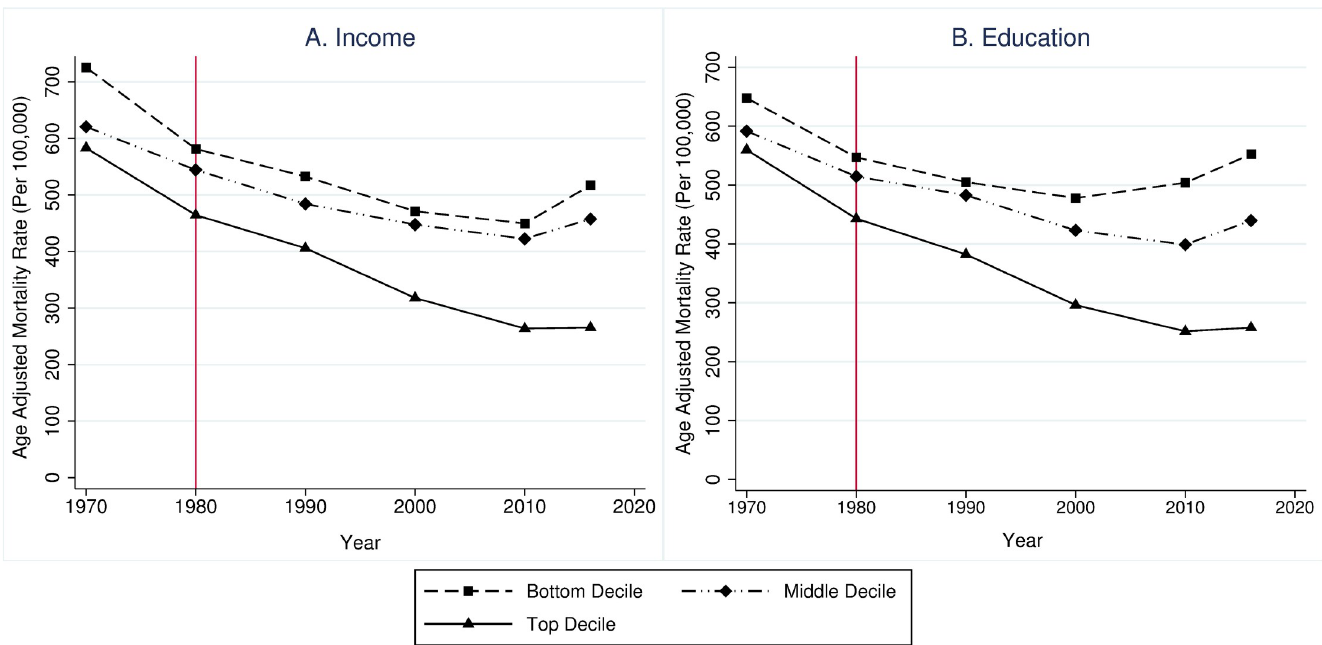
Fig 2. Age-adjusted mortality rates for working-age adults (ages 25–64 years) by county of residence per capital income and educational deciles, 1970–2016. County-level age-adjusted, all-cause mortality rates for adults ages 25–64 years were obtained from the US Centers for Disease Control WONDER database. Data on county-level per-capita incomes and share of individuals with some college education or greater were obtained from US Decennial Census and ACS data made available through Social Explorer. We assigned counties into deciles of the per-capita income and education variations by each census-ACS year (so a given county could be grouped into different deciles in different years). This operationalization is particularly important for level of education, as focusing on fixed educated groups (e.g., high school or less) may result in selection bias [58]. Population-weighted average mortality rates were then calculated for each socioeconomic decile-year. We then plotted these average mortality rates for the bottom (1st), middle (5th), and top (10th) decile of each socioeconomic variable. After the 1980s, the beginning of which is marked by the vertical red lines, income and education disparities began widening. ACS, American Community Survey; WONDER, Wide-Ranging Online Data for Epidemiologic